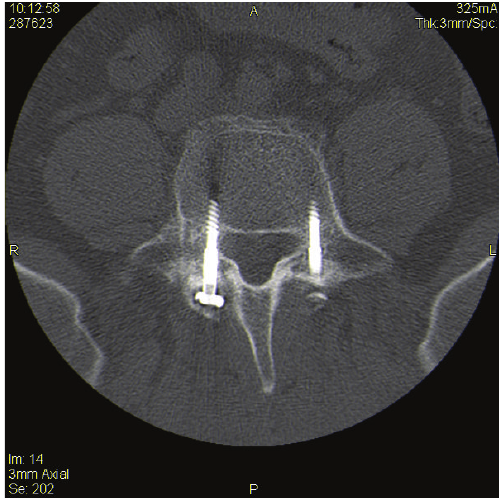
Figure 8: Sagittal view of left lumbar fixation screw in